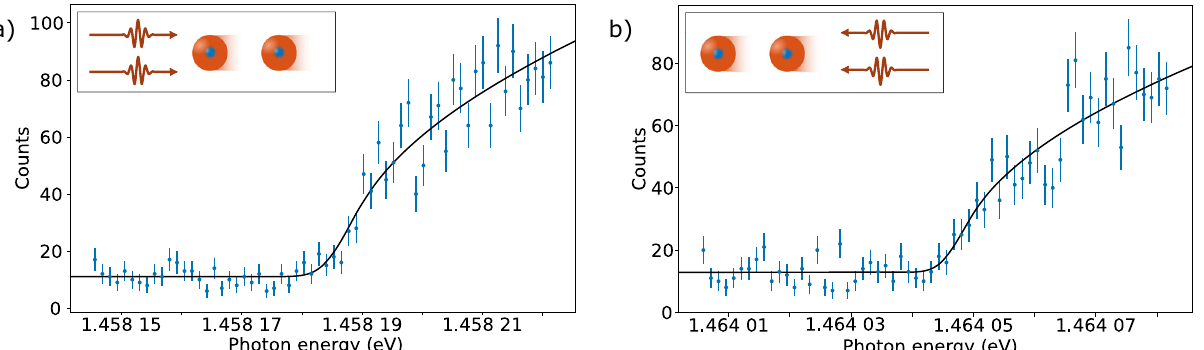
Fig.3|Examplesoftwosinglethresholdscans. Thelaserpropagatesanti-parallel ( a ) or parallel ( b ) with respect to the ion beam. The data shown in blue are binned using300MHz(1.24 μ eV)binsanda fi tusingaconvolutionbetweentheWignerlaw and a Gaussian distribution isshown in black.The errorbars are the square root of 228 thresholds gives an electron af fi nity of 1.461,112,972(45)eV where